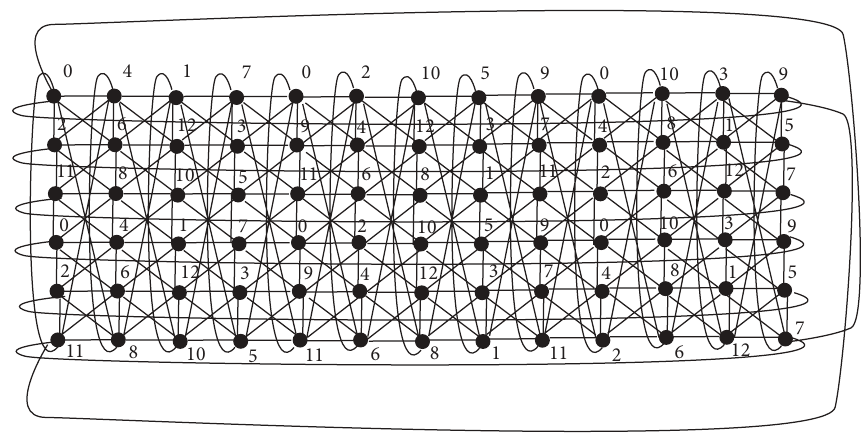
Figure 1: Strong product 𝐶 6 ⊠ 𝐶 13 with a 12 - 𝐿(2,1)